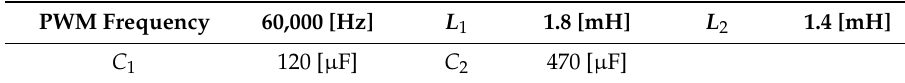
Table 2. The converter